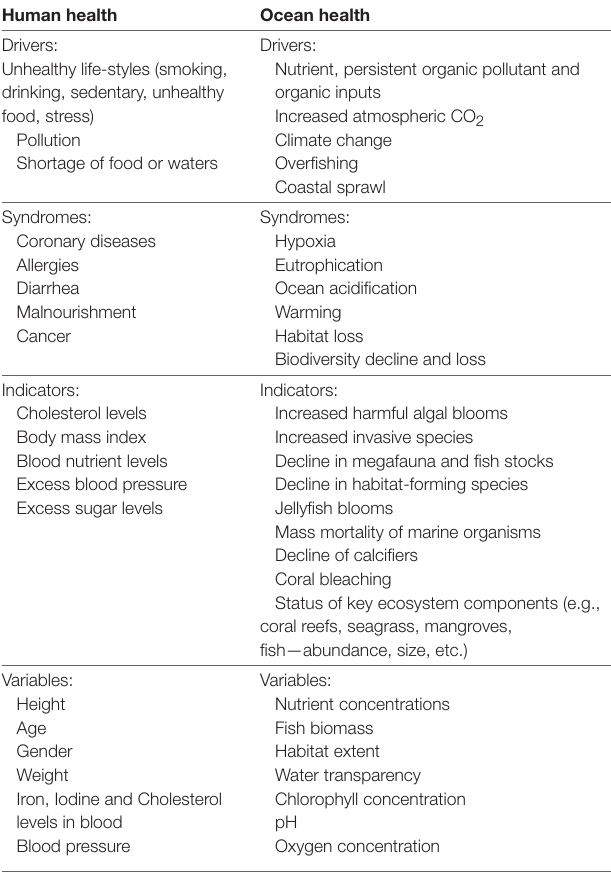
TABLE 1 | Comparison between drivers, syndromes, and indicators of human and ocean